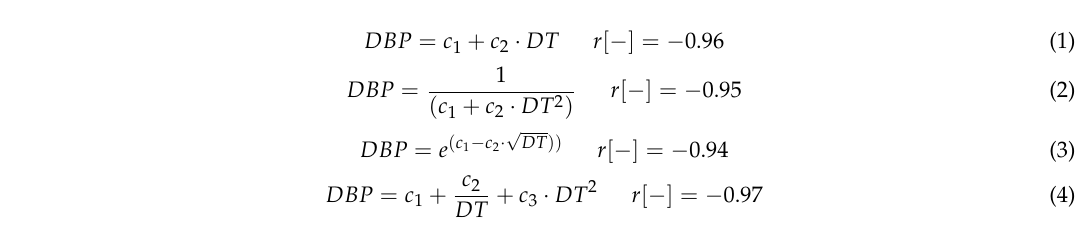
Table 2. Various models and correlation coefficients of the fit to the measured